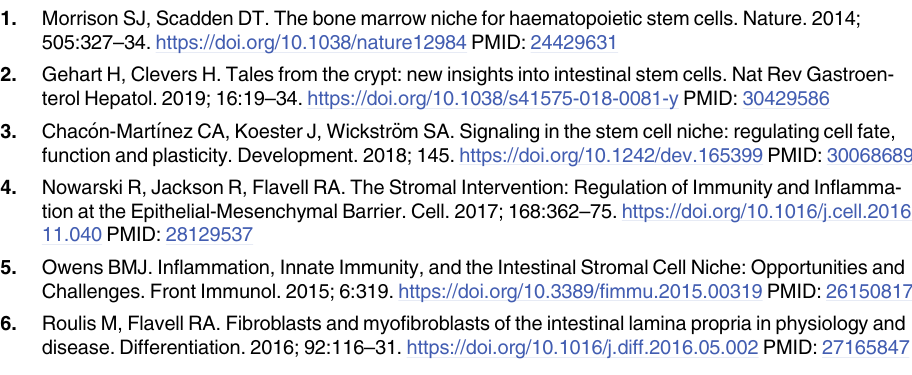
S2 Table. DEGs between water- and chronic DSS-treated fibroblast clusters. DEG, differen- tially expressed gene; DSS, dextran sulfate sodium. S3 Table. DEGs between water- and DSS-treated stromal clusters. DEG, differentially expressed gene; DSS, dextran sulfate sodium. S4 Table. Genes associated with MAF-to-MyoF differentiation. MAF, mucosa-associated fibroblast; MyoF, myofibroblast. (XLSX) S1 Data. Source data for Fig 6B and 6C and S10B Fig.